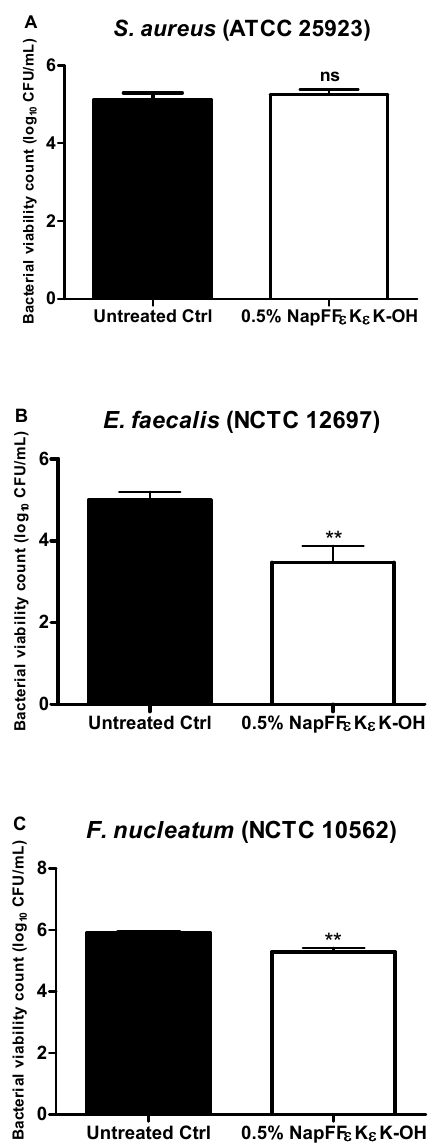
Figure 5. Bacterial viability counts (Log10 CFU/mL) for ( A ) S. aureus , ( B ) E. faecalis and ( C ) F. nucleatum after 24 h growth on the surface of 0.5% w / v NapFF ε K ε K-OH hydrogels. Results are the average ( ± standard error) of three independent experiments (three replicates per experiment). All comparisons were made with untreated controls. Mann–Whitney non parametric testing was employed for statistical analysis. ns: no significant difference ( p > 0.05), **: p ≤ 0.01.